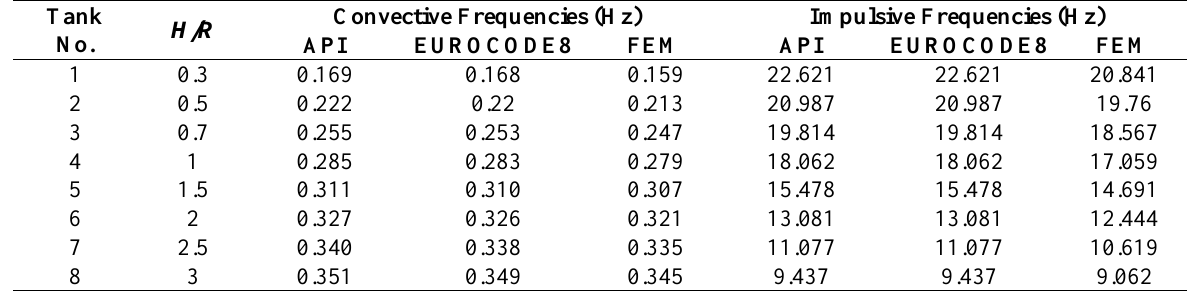
Impulsive Frequencies (Hz) Convective Frequencies (Hz)